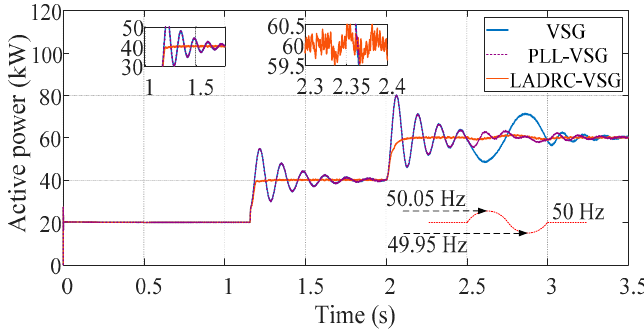
Figure 23. Output power of VSG under different control strategies.